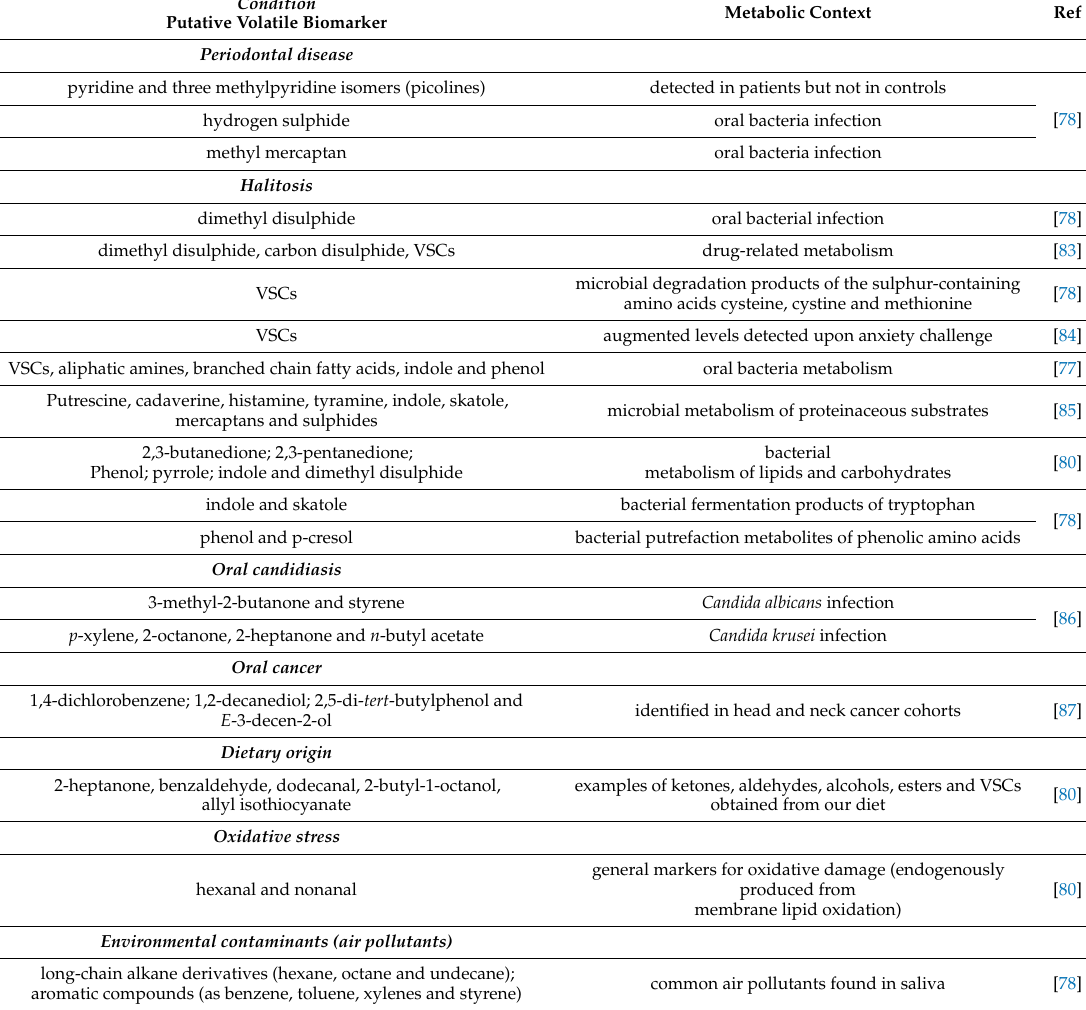
Table 1. Relevant salivary VOCs with potential for oral disease